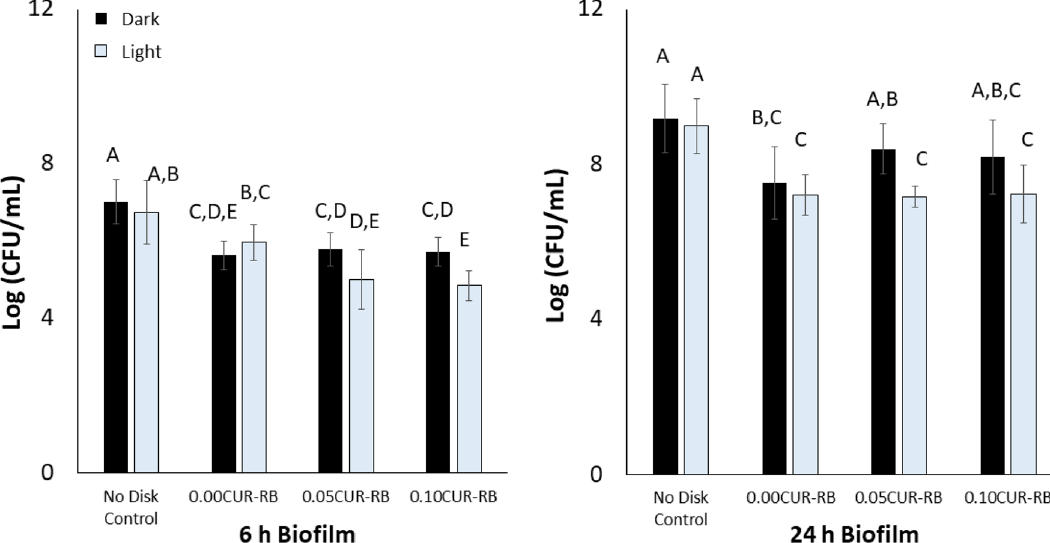
Figure 6. CFU/mL count as a function of curcumin concentration and application of light following 6 h (left) and 24 h (right) biofilm development. Data is presented as average (CFU/mL) ± one standard deviation (n = 9). Means that are detectably different (p < 0.05) are assigned different letters.